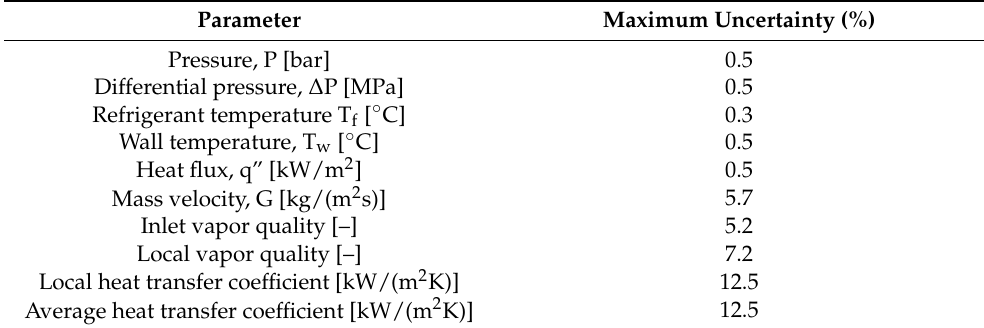
Table 3. Measurement error and